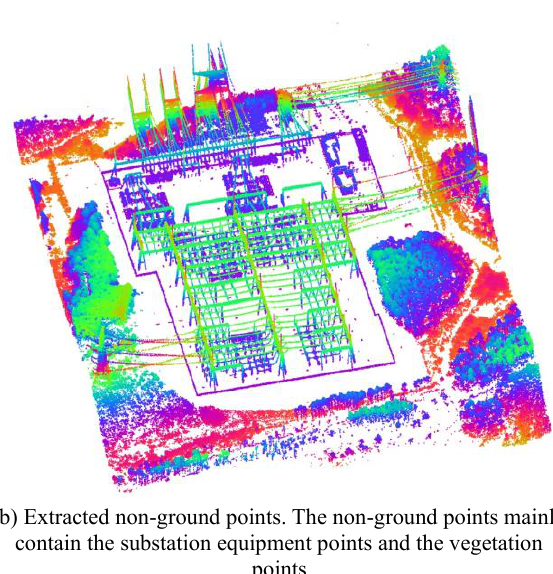
Figure 4. Morphological filtering of the point clouds Figure 5 shows the result of substation area extraction based on point cloud normal consistency estimation. Figure 5 (a) is the top view of the extracted ground point cloud data of the substation area. Through the constraint of normal vector in vertical direction, the irrelevant point cloud data outside the substation area are filtered out. Figure 5 (b) is a side view of the extracted results. It can be seen that the extracted results have good consistency in the elevation direction, which conforms to the flat characteristics of the substation area.